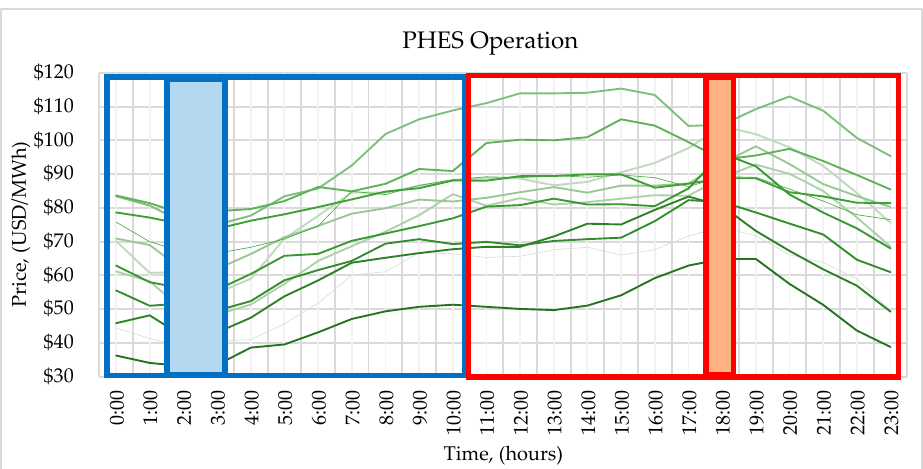
Figure 11 . Representation of the optimization model . Own source with CENACE information, Figure 11. Representation of the optimization model. Own source with CENACE information,